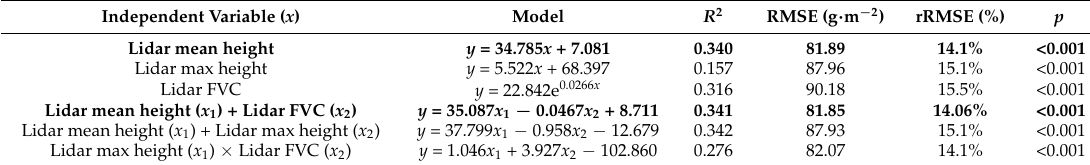
Table 4. Linear and nonlinear regression analyses between the lidar-derived parameters and the field-measured biomass.